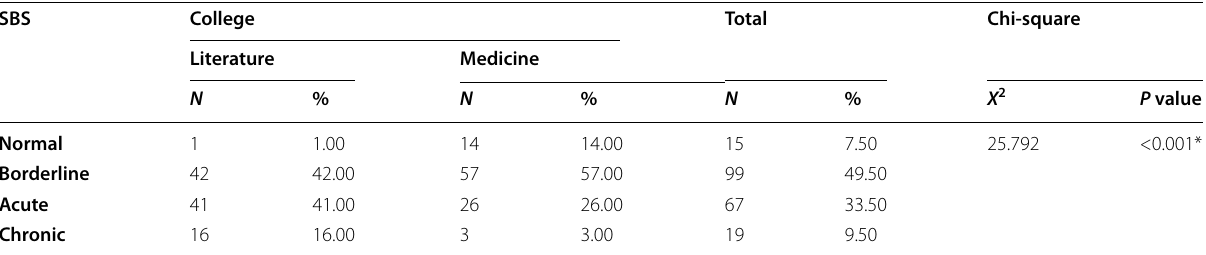
Table 4 Prevalence of the selfie phenomenon using the Selfie Behavioral Scale (SBS) between both